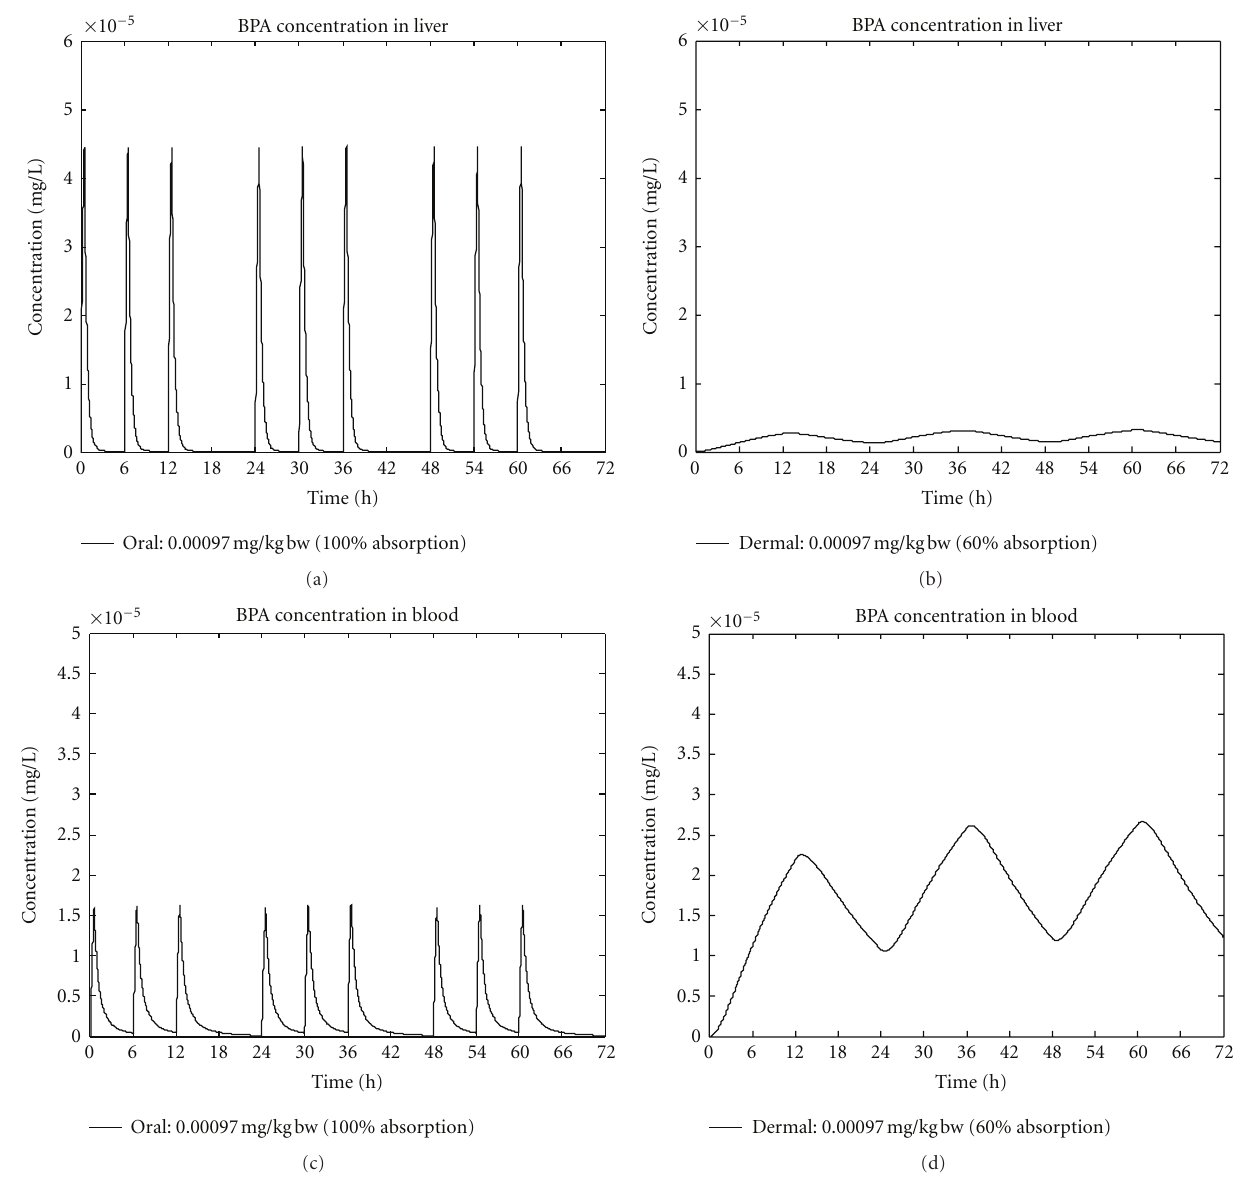
Figure 1: BPA: simulation results oral versus dermal route. Humans are exposed towards BPA on the oral and on the dermal